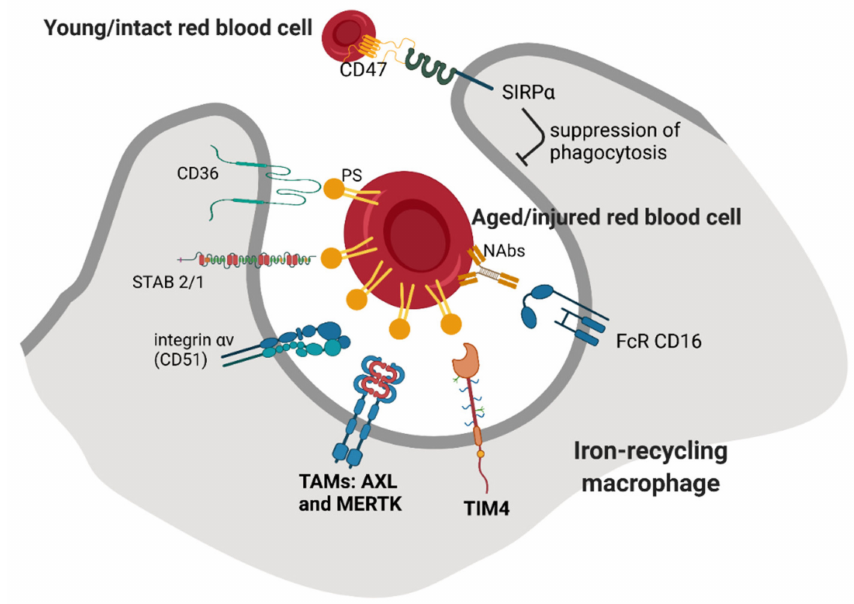
Figure 2. Recognition of red blood cells’ biochemical integrity by iron-recycling macrophages. Aged/injured erythrocytes expose exoplasmic phosphatidylserine (PS) on their surface and become opsonized by naturally occurring antibodies (NAbs). Among the cognate receptors for these senes- cence signals that are expressed on RPMs and KCs, TAM receptors AXL and MERTK, TIM4 and Fc receptor CD16 are the most abundant. A “don’t eat me” signal that prevents the clearance of young and intact erythrocytes is provided by the interaction between SIRP α at the surface of the macrophage with CD47 expressed by